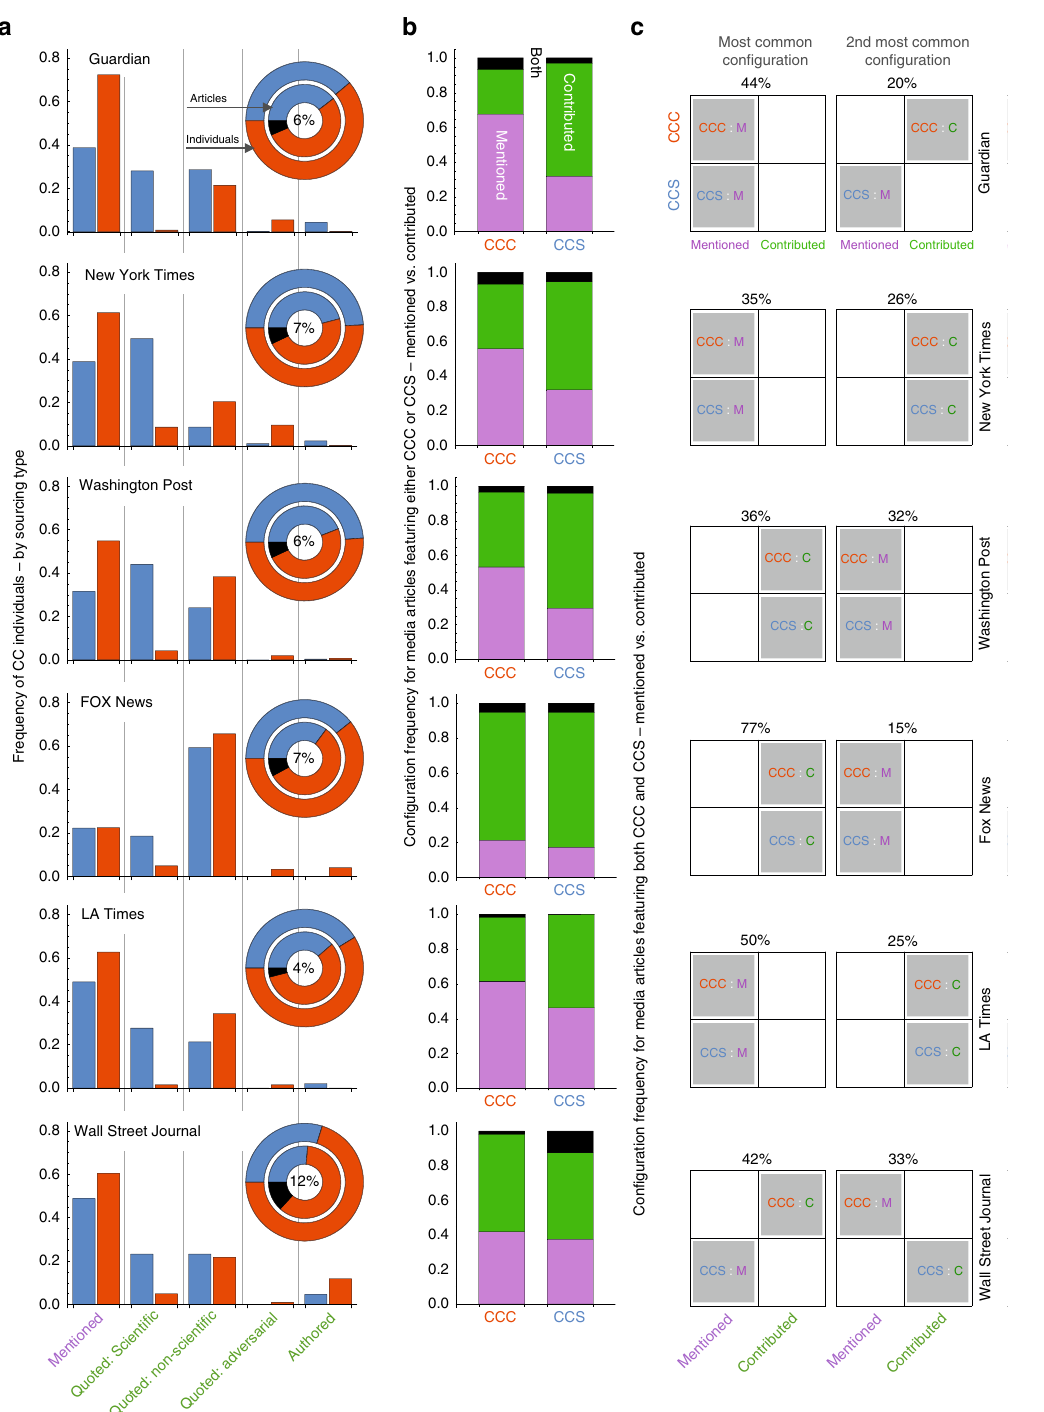
Fig. 5 How climate change contrarians (CCCs) and climate change scientists (CCSs) are sourced in CC articles — by media source. a Frequency distribution showing how individuals are sourced in media articles according to fi ve types separated into two categories: mentioned (purple) and contributed (green). Pie-chart insets: The outer ring indicates the fraction of individuals analyzed by group; the inner ring indicates the fraction of articles analyzed featuring individuals from just CCCs (red arc), just CCSs (blue arc), or both groups (black arc, with this percent value indicated at the center). b The frequency of three sourcing con fi gurations for unbalanced articles featuring either CCCs or CCSs but not both. The black segment indicates the frequency of articles featuring mentioned and contributing individuals. c The two most common sourcing con fi gurations for balanced articles featuring both CCCs and CCSs. For example, articles with CCCs and CCSs mentioned is the most frequent con fi guration for The Guardian, which occurred in 44% of the articles featuring both CCCs and CCSs; the second most frequent con fi guration featured CCCs contributing and CCSs being mentioned (20%)